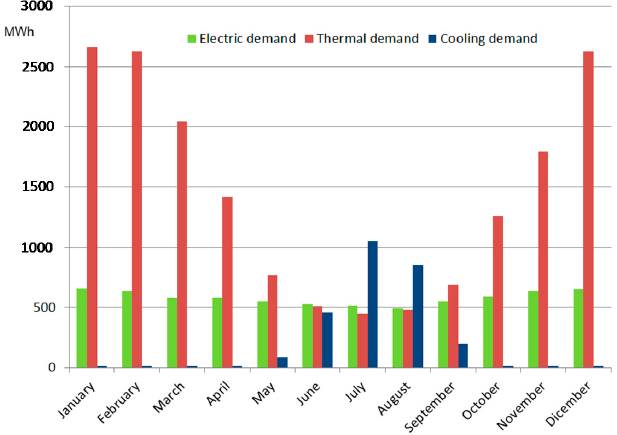
Figure 3. Trends of electric, thermal and cooling energy demands.